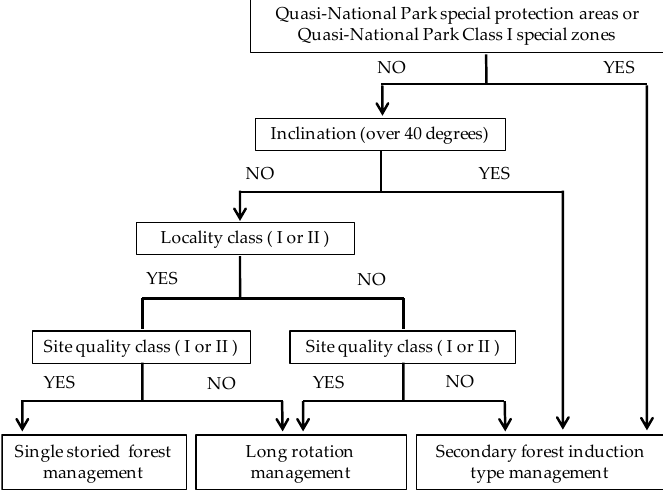
Figure 5. Environmental conservation plan (Plan 3).